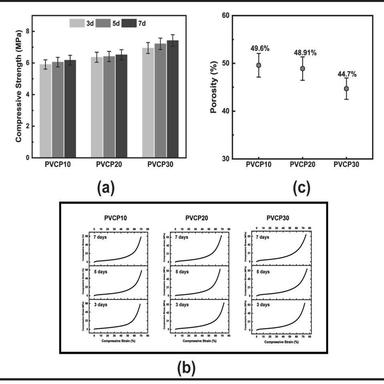
a) The compressive strengths of CPS-PVDF scaffold after 3, 5, and 7 d of hydration at 30% deformation. b) The compressive strength curves of all CPS-PVDF samples with respect to strain. c) The porosities of CPS-PVDF scaffold after 7 days of hydration. The error bar represents one standard deviation (n = 4).